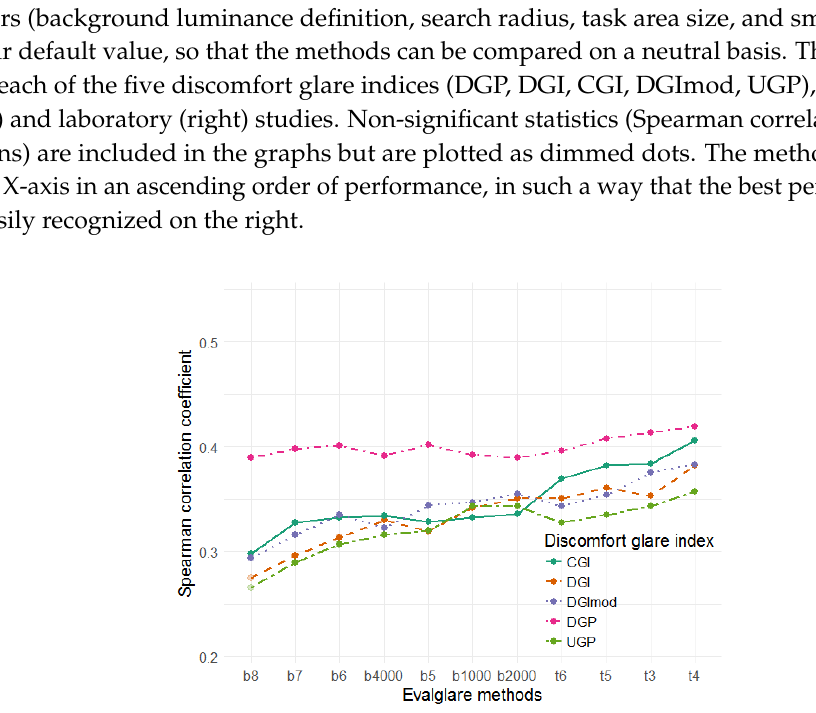
Figure 4. Comparison of Spearman rho for each discomfort glare index between the studied evalglare methods (field study).